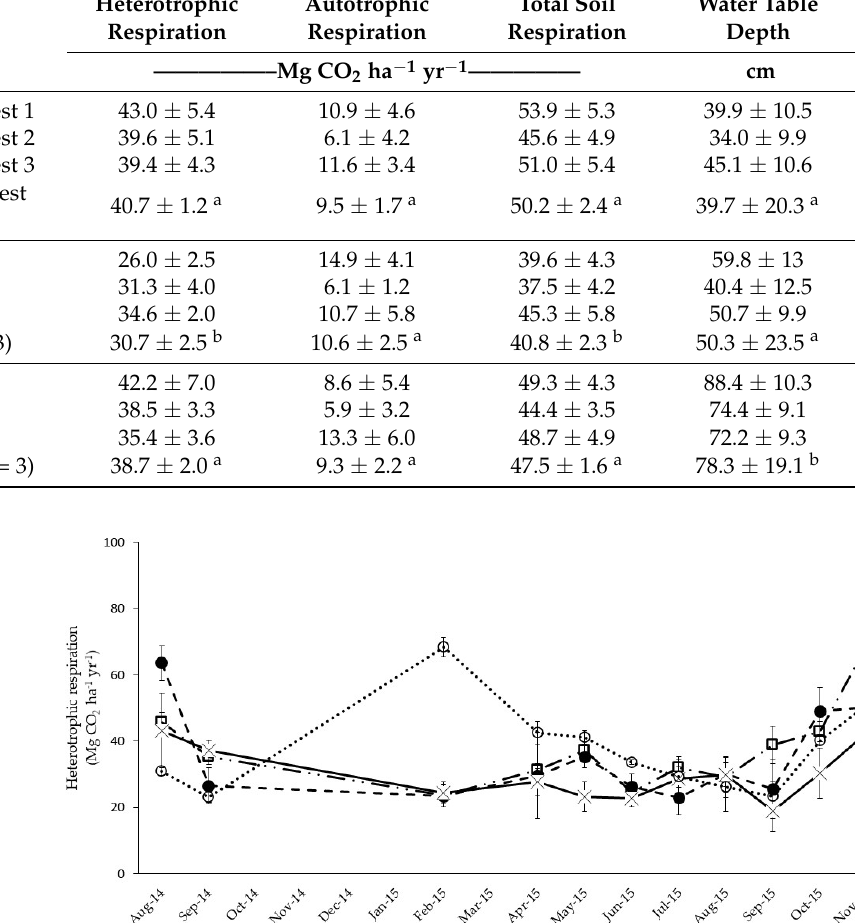
Table 2. Heterotrophic, autotrophic, and total respiration, water table depth, and mean soil temperature in intact forest, logged peat forest, early seral, and oil palm estate are reported as mean ± one standard error. Different lower-case letters represent the statistically significant difference ( p < 0.05) on a variable among land use types. Water Table Table 2. Cont. Water Table